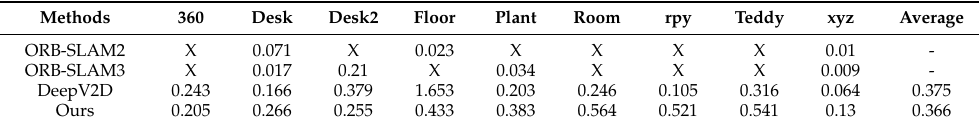
Figure 10. Full SLAM result. Table 2. ATE on the TUM-RGBD benchmark. Failures are recorded as